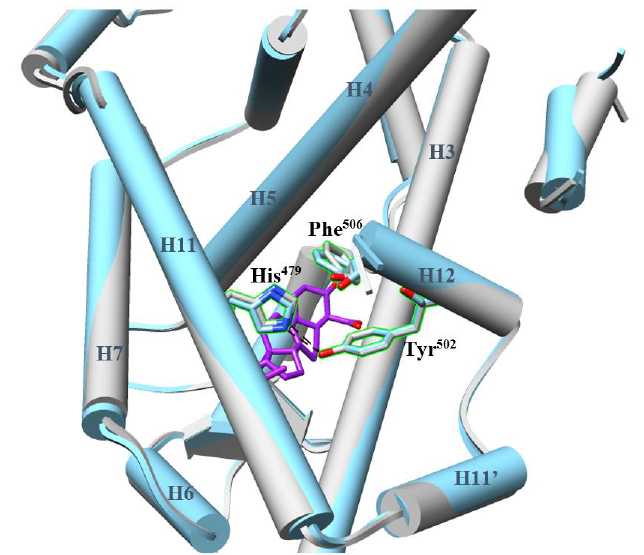
Figure 4. The conformational change of ROR γ LBD before and after agonist binding in the orthosteric pocket is minimal. The LBD (PDB 4S14, cyan) bound with the agonist (purple) is superimposed against the apo LBD (grey). The backbones of the LBD are presented in cylinder shape, while the agonist and the residues His 479 , Tyr 502 and Phe 506 are in stick shape. The agonist retains the architecture of the pocket and the hydrogen bond of the agonist lock (shown as black dashed lines).